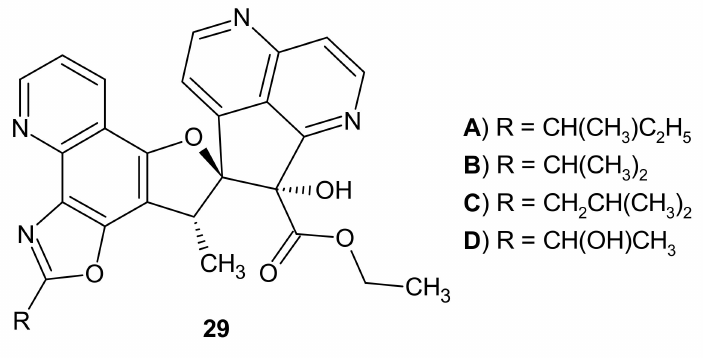
Figure 9. Structures of aaptodine A-D 29